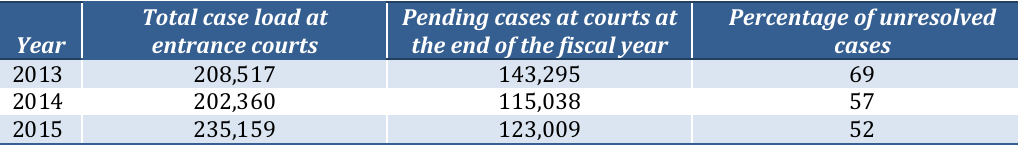
Table 5: Caseload at the entrance courts in capital cities and El Alto, 2013 ‐ 2015 Total case load at Pending cases at courts at Year entrance courts the end of the fiscal year